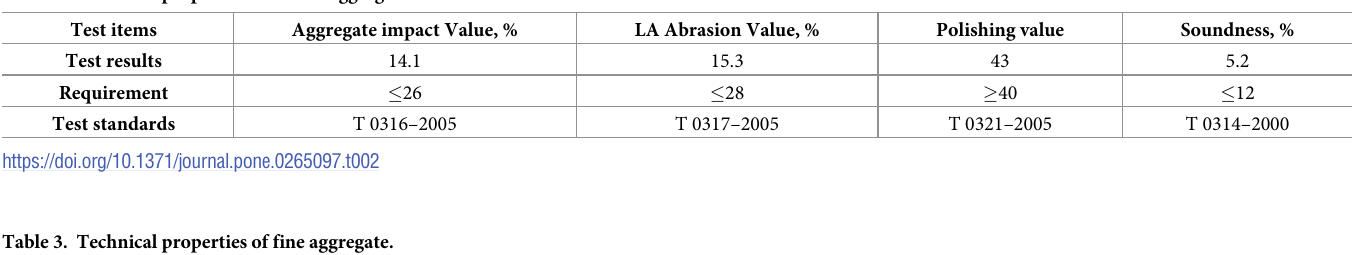
Table 2. Technical properties of coarse aggregate.